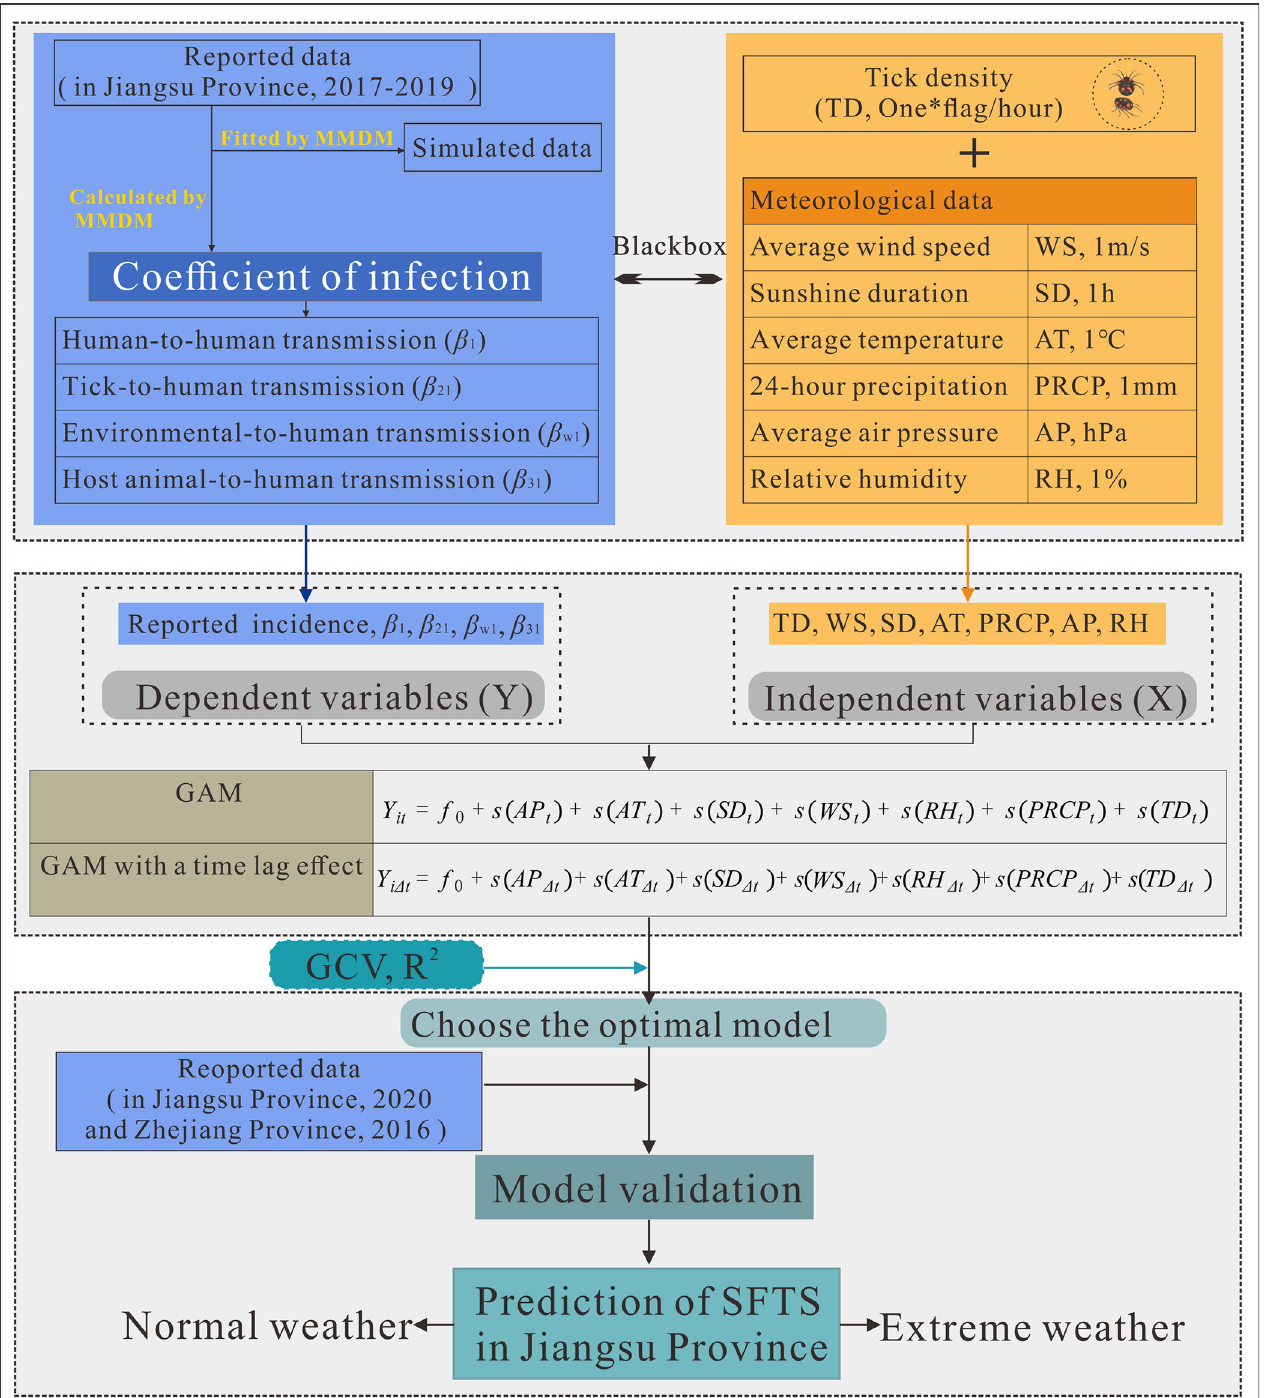
Fig 1. Study design of meteorological factors and tick density affect the SFTS transmission. SD = Sunshine duration, RH = Relative humidity, AT = Average temperature, PRCP = 24-hour precipitation, WS = Wind speed, TD = Tick density, and GCV = generalized cross-validation score; GAM: Generalized additive model; MMDM: Multi-population and multi-route dynamic model of SFTS.